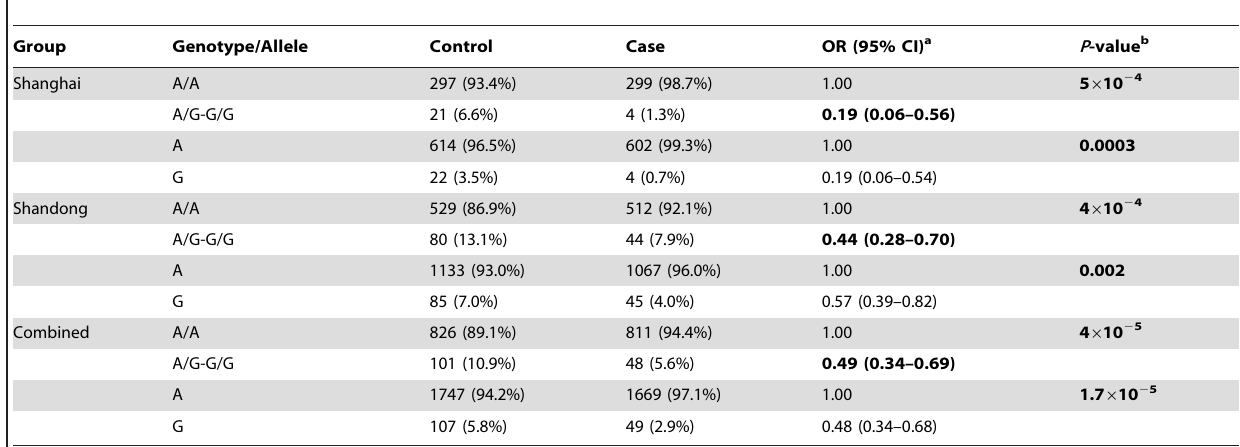
Table 2. Associations between variant rs11254363 of CUBN and CHD in two independent case-control studies.